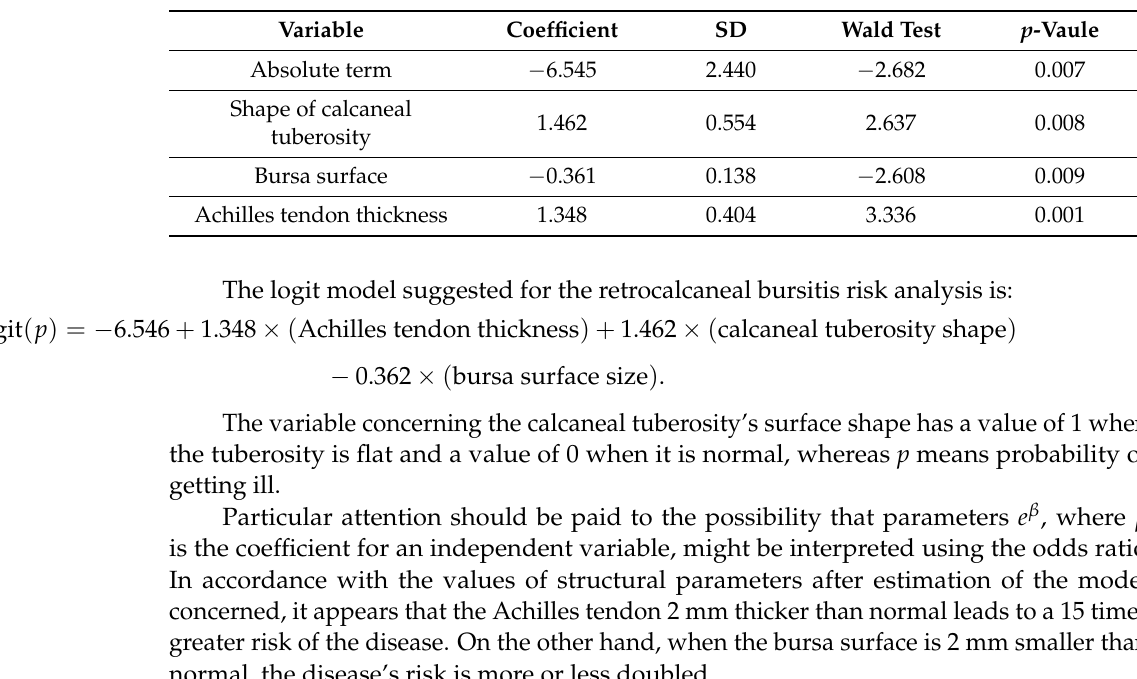
Table 3. Assessment of significance of variables selected for the model based on Wald